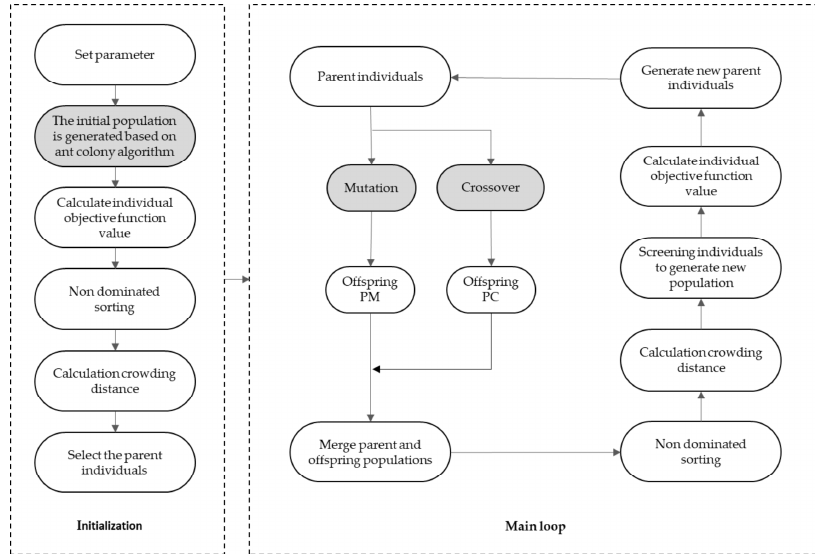
Mathematics 2022 , 10 , x FOR PEER REVIEW